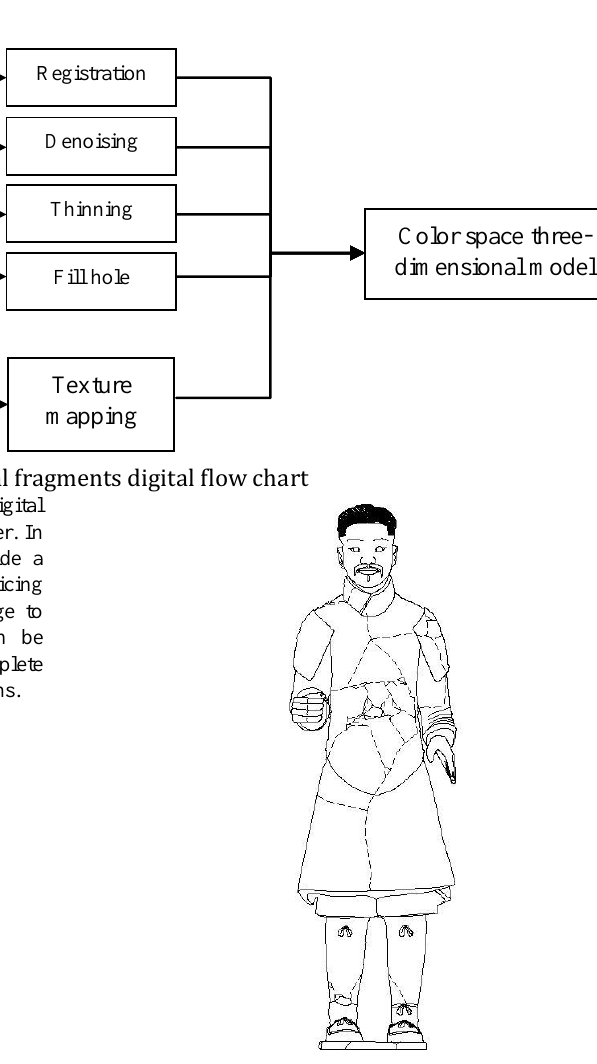
Figure 2 Line Map of Terracotta Army